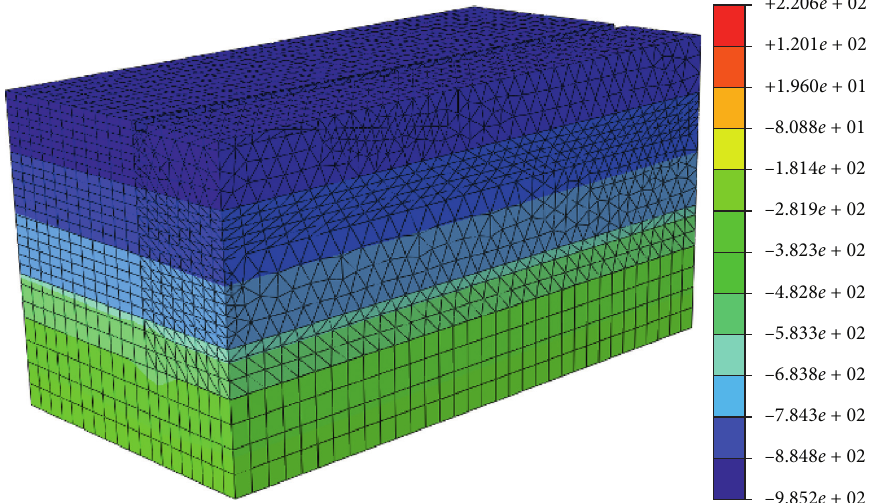
Figure 19: Vertical stress contours (unit: kPa).